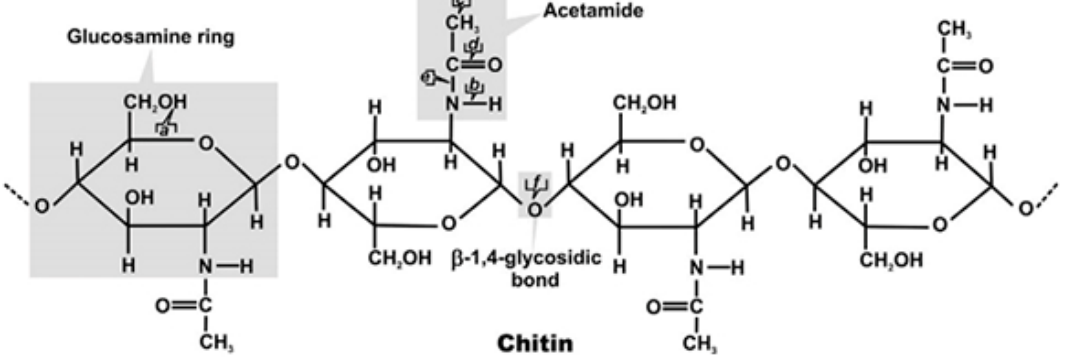
Figure 1. Chemical structure of chitin [20].